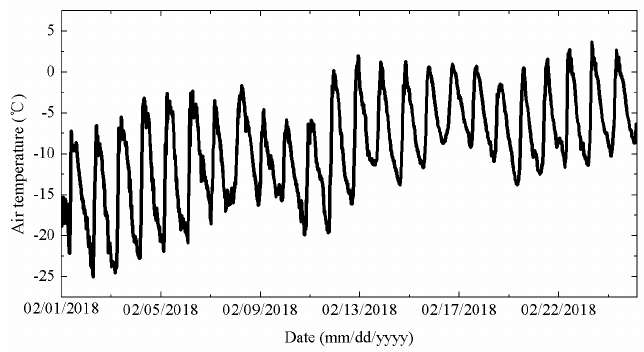
Figure 14. Air temperature measured by TYUT thermistor string from 1 February to 25 February.